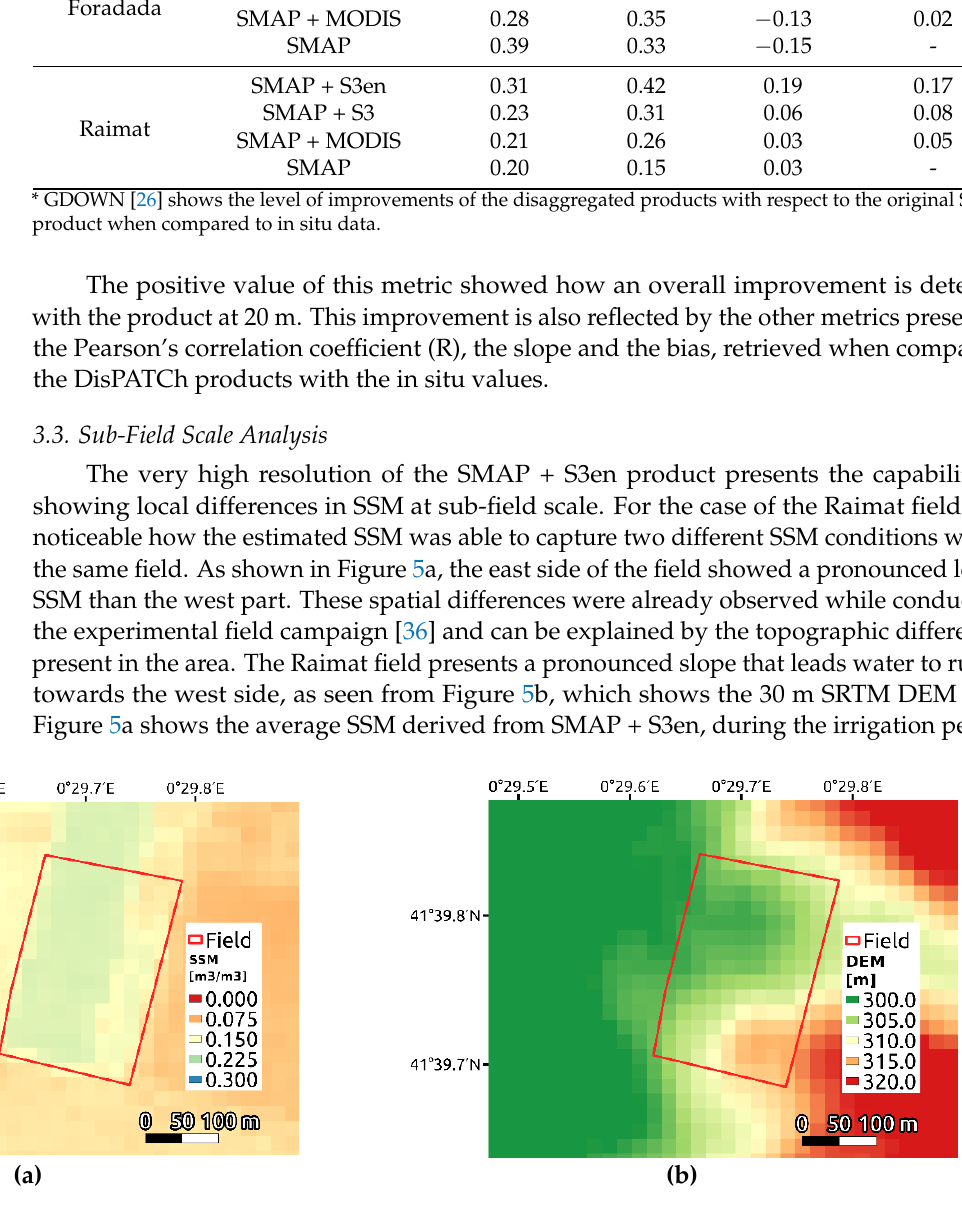
Figure 5. Sub-field scale analysis. ( a ) Average of SMAP+S3en SSM during the 2018 irrigation